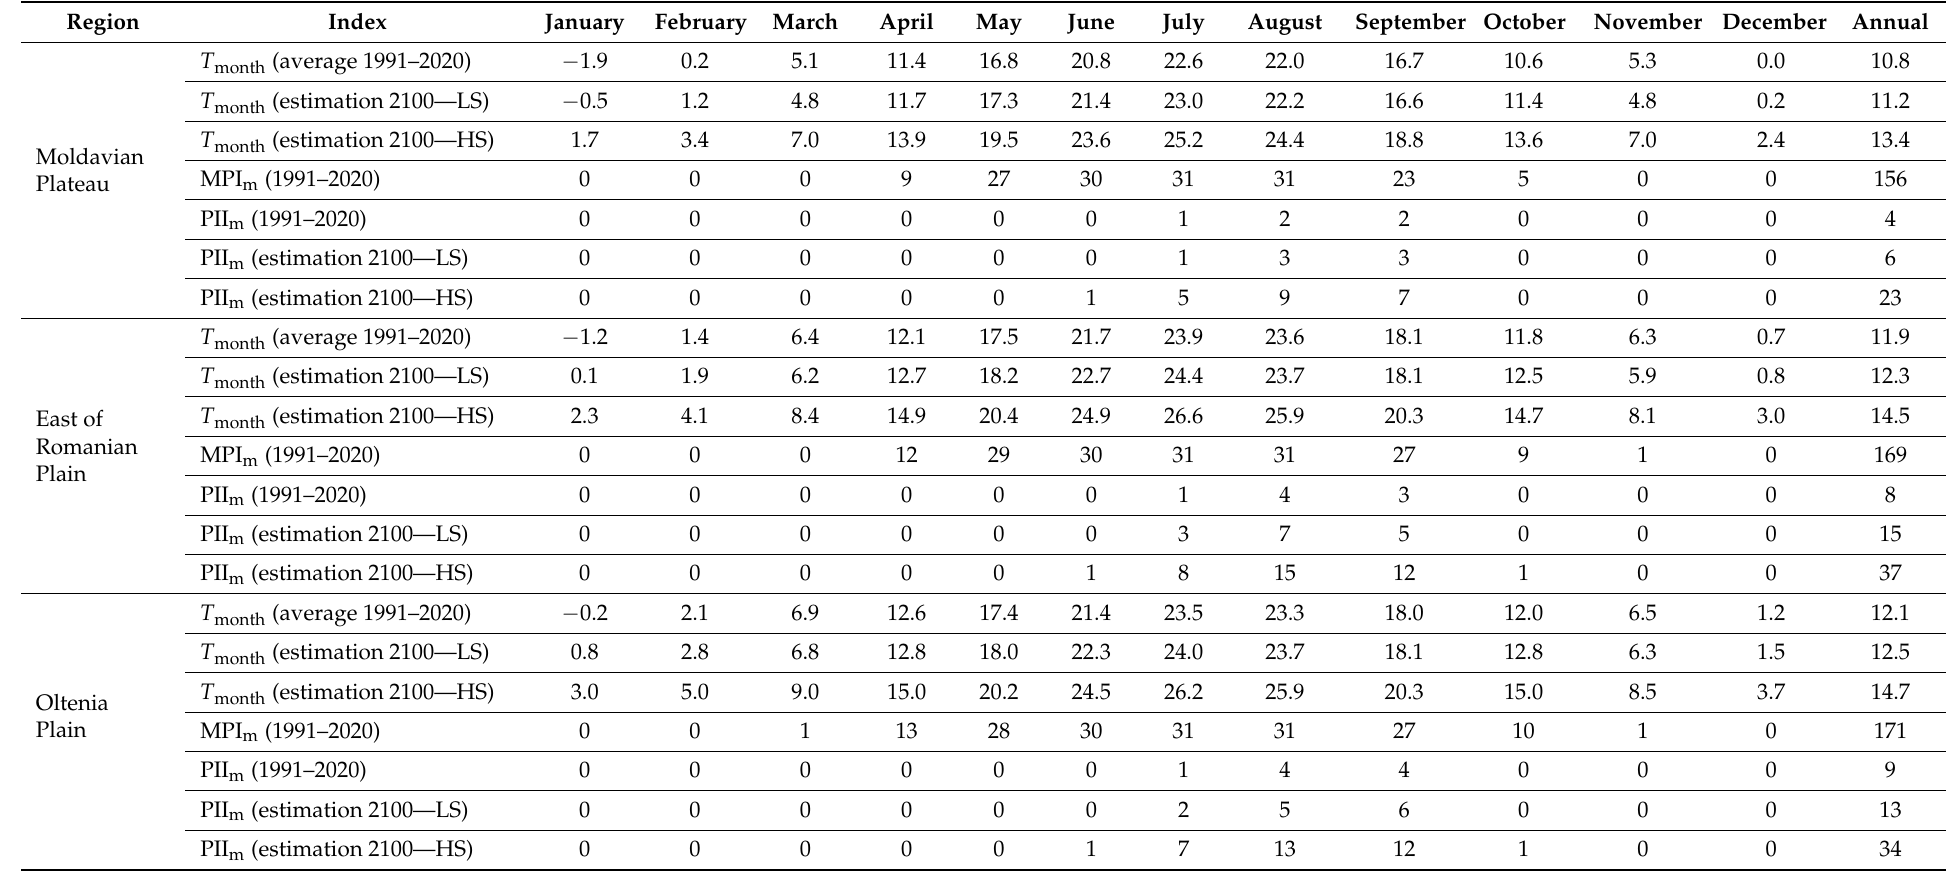
Table 1. Bioclimatic and temperature indices for 1991–2020 and estimates for